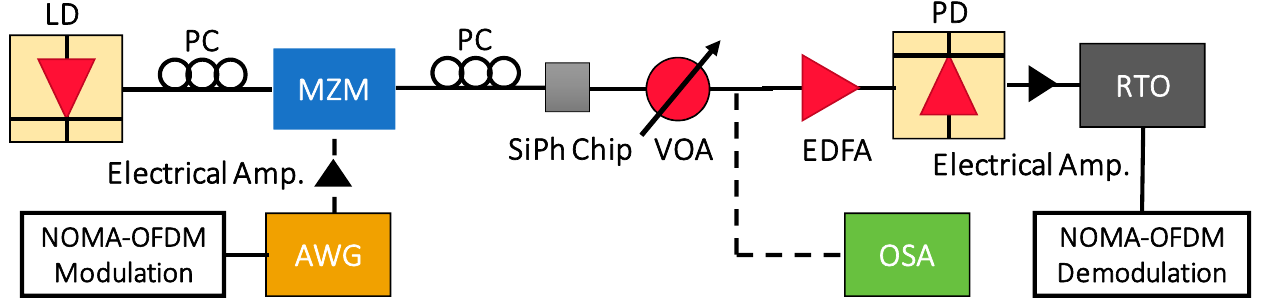
Figure 8. Experimental setup of the proof-of-concept NOMA-OFDM transmission with two MDM modes and two NOMA users, in the MDM device with sharp Euler bends. LD: laser diode; MZM: Mach–Zehnder modulator; AWG: arbitrary waveform generator; VOA: variable optical attenuator; PC: polarization controller; EDFA: erbium-doped fiber amplifier; OSA: optical spectrum analyzer; RTO: real-time oscilloscope; PD: photodiode.